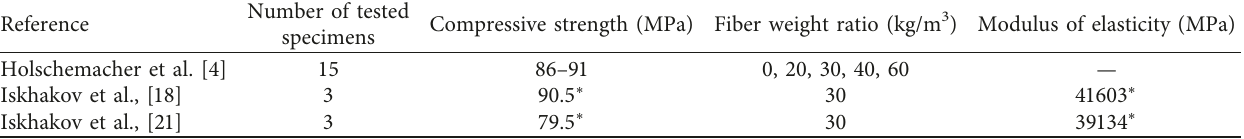
Table 2: Available data from testing HSC cylindrical specimens.